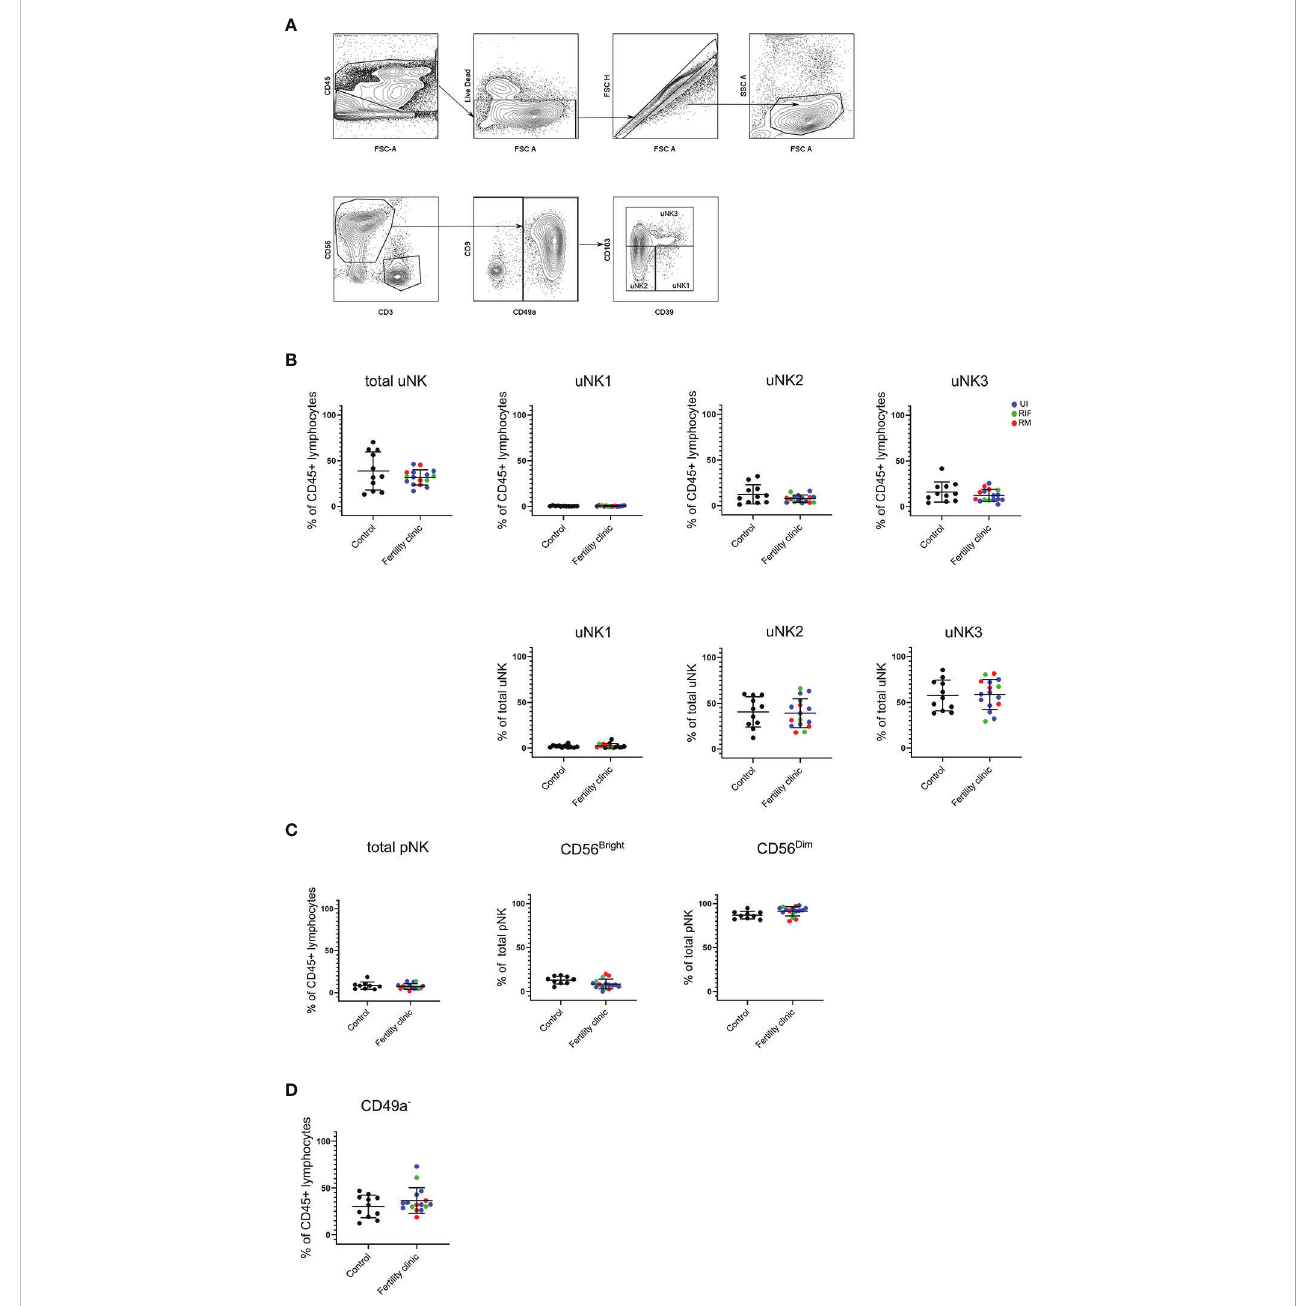
FIGURE 1 uNK and pNK proportion in unexplained subfertility, recurrent miscarriage and implantation failure compared to controls (A) FACs gating strategy used to identify three uNK subsets (representative example shown) (B) Graphs of total uNK from CD45+ lymphocytes then frequency of each uNK subset (uNK1, -2, -3) as proportion of CD45+ lymphocytes and proportion of total uNK. (C) Graphs of total pNK from CD45+ lymphocytes then frequency of CD56 Bright and CD56 Dim as proportion of total pNK. (D) Graph of CD3-CD56+CD49a- lymphocytes as proportion of total uNK. Means and standard deviations are shown for controls (n=11) shown in black and patients from fertility clinic including unexplained infertility (UI; n=9) showed in blue, recurrent miscarriage (RM; n=34) shown in red and recurrent implantation failure (RIF; n=3) shown in green. Statistical testing was done using unpaired t- test for normal or Mann-Whitney U test for non-normal distribution and showed no signi fi cant difference in any of the